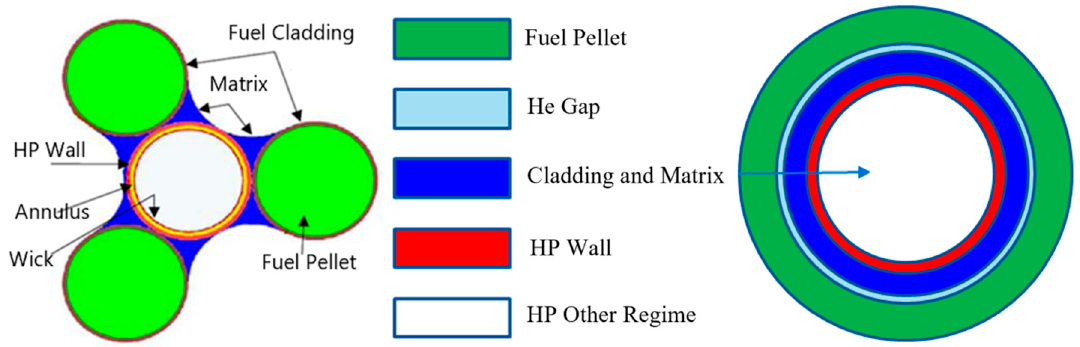
Figure 4. Schematic of equivalent heat transfer model for the heat pipe fuel assembly.